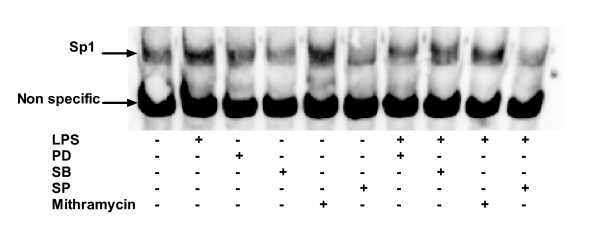
Sp1 binding activity in nuclear proteins of HAM. HAM were preincubated 1 h or not with inhibitors (50 μM for PD98059, SB203580 and SP600125 or 500 nM for mithramycin) and then stimulated with LPS (1 μg/ml) during 2 hours. Control HAM were HAM cultured with medium alone. Nuclear proteins were extracted as previously described and were then incubated in the binding buffer with specific labelled probe and then subjected to electrophoresis for separation of the complexes.